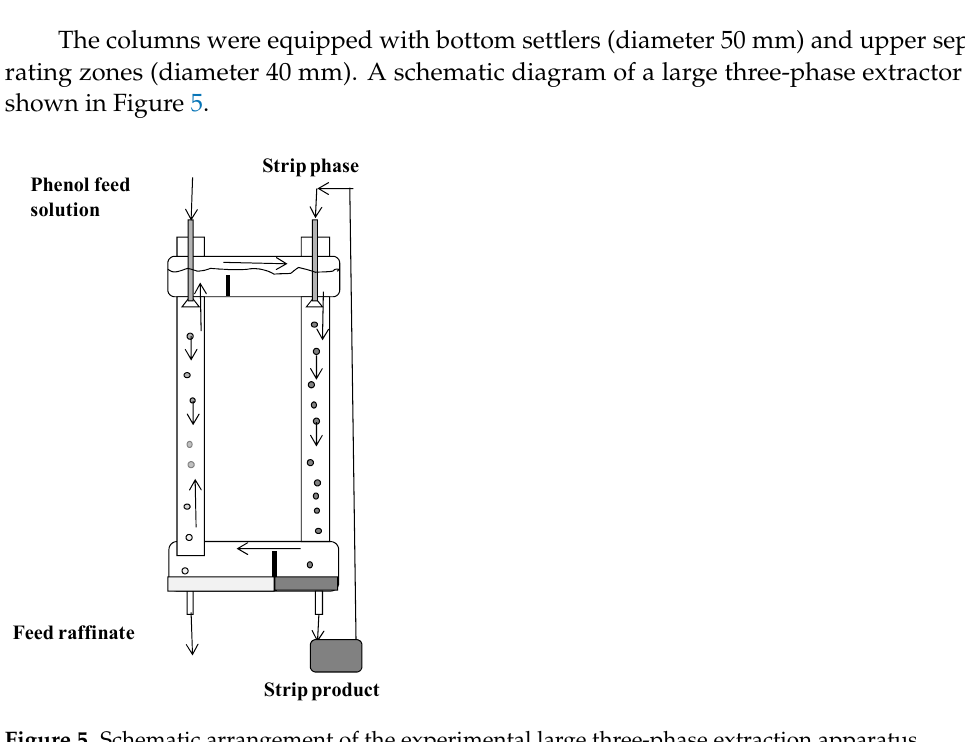
Figure 5. Schematic arrangement of the experimental large three-phase extraction apparatus. In this apparatus, the extraction and stripping chambers are connected at the bottom by a common horizontal cylindrical settling tank (diameter 80 mm), and at the top by a separator of a similar design (column height 900 mm, diameter 30 mm). The volume of the organic phase in the small apparatus was 0.85–0.9 L, and in the large apparatus it was 3.4 L. Dispersion of aqueous phases in the chambers in both apparatuses was carried out using fluoroplastic distributors with hole diameters ( d e and d s ) of 1, 2, and 3